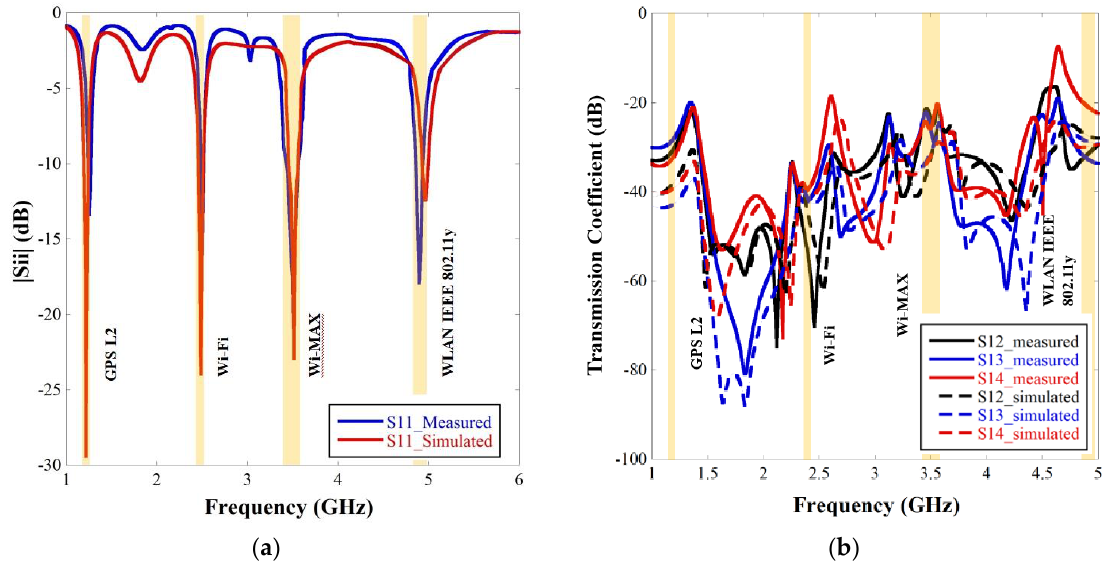
Figure 11. Comparison scattering parameter graphs of the measurement results of the fabricated prototype and simulated results of the four element MIMO with parasitic microstrip line: ( a ) |Sii| graph and ( b ) Transmission coefficient graph.